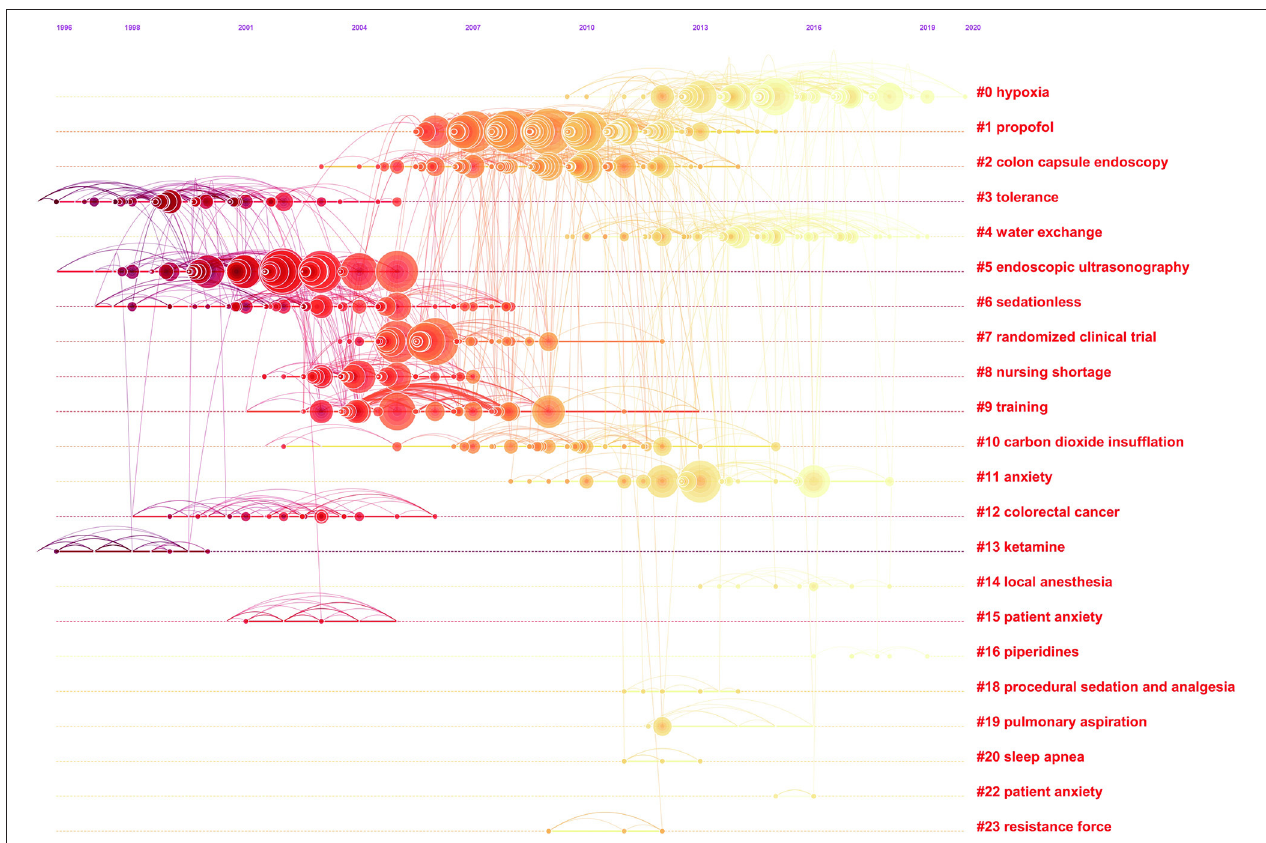
FIGURE 8 | The timeline view of co-citation clusters with their cluster-labels on the